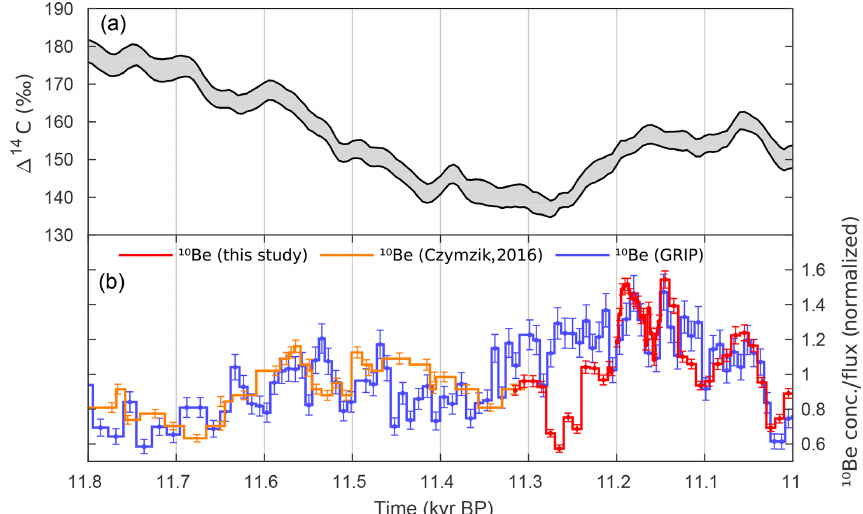
Figure 1. (a) The IntCal13 calibration curve (Reimer et al., 2013) expressed as (cid:49) 14 C (see text). (b) The 10 Be concentration data from Meerfelder Maar (MFM), spanning the period 11310–11000 years BP, are plotted in red with corresponding measurement error bars. The record is completed in orange with the 10 Be measurements from the same sediment profile for the late glacial–Holocene transition (Czymzik et al., 2016). The MFM 10 Be data are plotted on the original MFM2012 chronology. The 10 Be flux data from the GRIP ice core in central Greenland (Adolphi et al., 2014) are plotted in blue and on the GICC05 timescale (Rasmussen et al., 2006; Vinther et al., 2006; Svensson et al., 2008; Seierstad et al., 2014). All records have been normalized to their